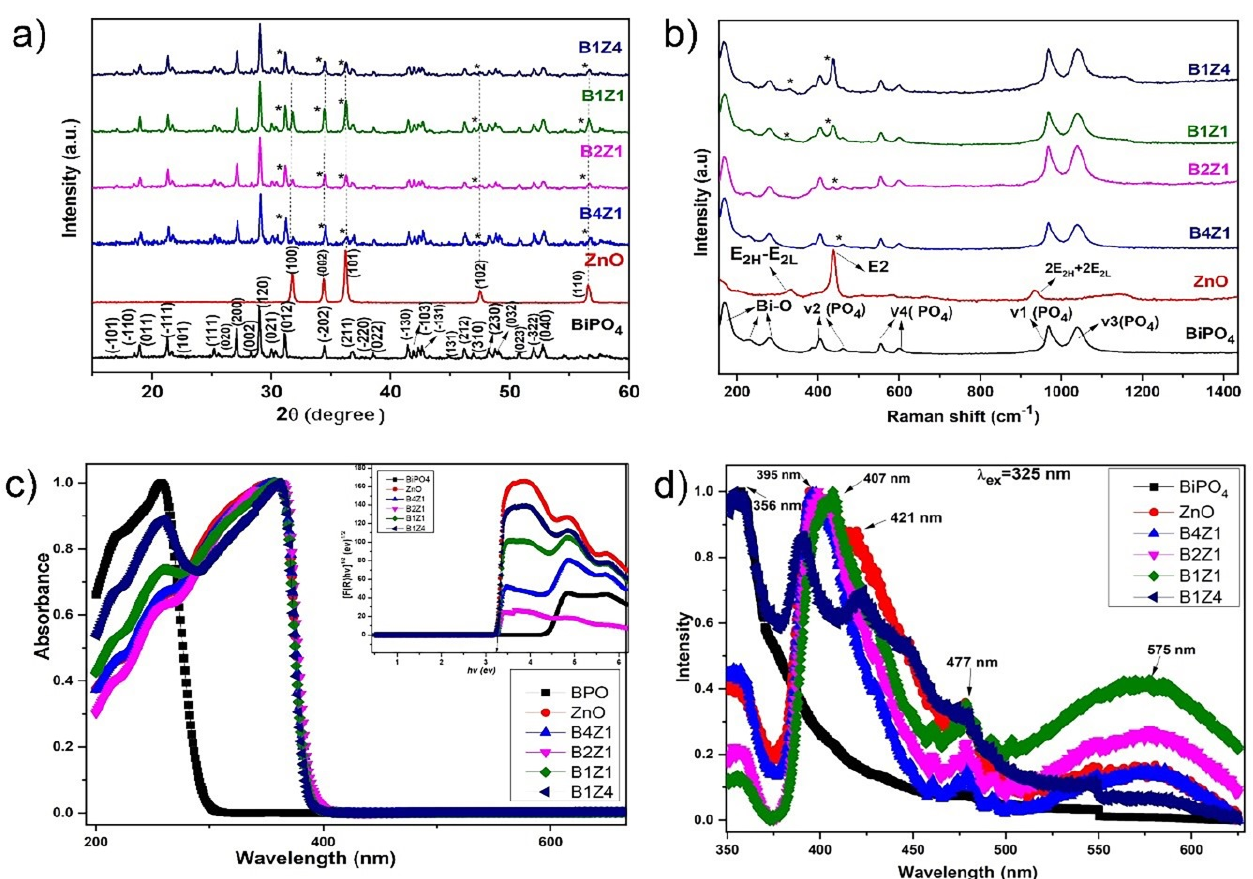
Figure 1. Characterization of synthesized NPs and different concentrations of BiPO 4 and ZnO load- ings of NCs: ( a ) X-ray diffraction pattern *; ( b ) Raman spectra; ( c ) UV–vis spectroscopy absorbance spectra; ( d ) photoluminescence (PL) spectra.